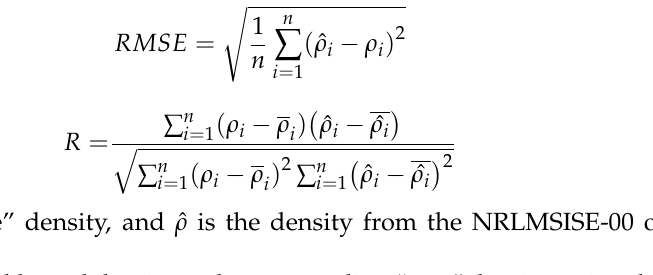
Figure 3. The trend of F10.7 and ap in 5